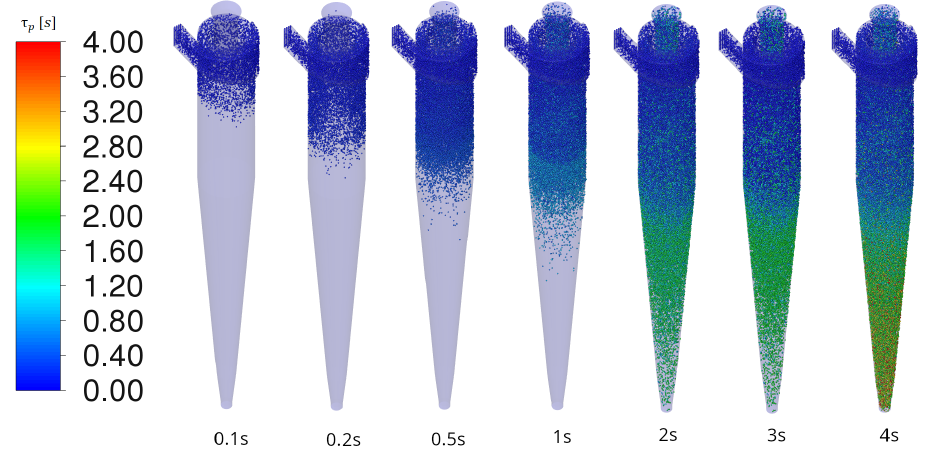
Figure 8. Particle flow coloured by particle residence time ( τ p ) at various flow-times after injection of